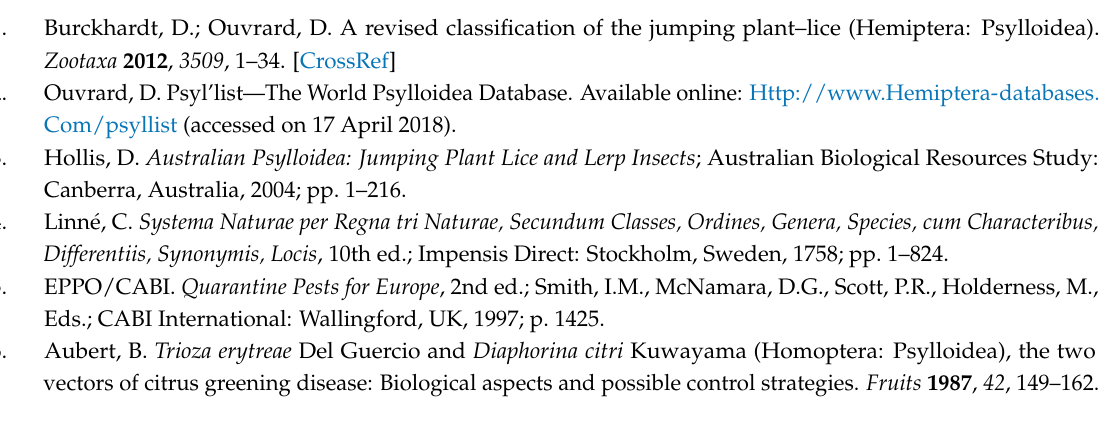
Supplementary Materials: Figure S1: COI gene tree (ML, 10,000 replicates, nodes <70% not reported). Table S1: Field